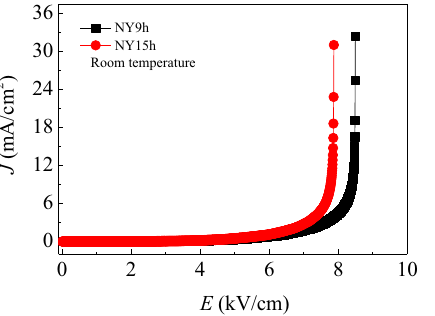
Figure 6. Nonlinear J – E properties of NY9h and NY15h ceramics at room temperature.